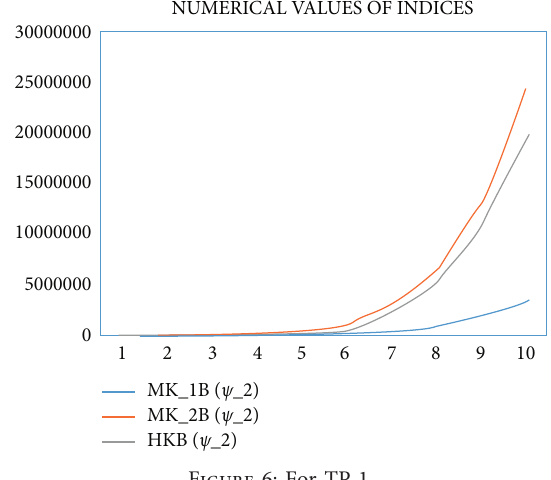
Figure 6: For TP 1.